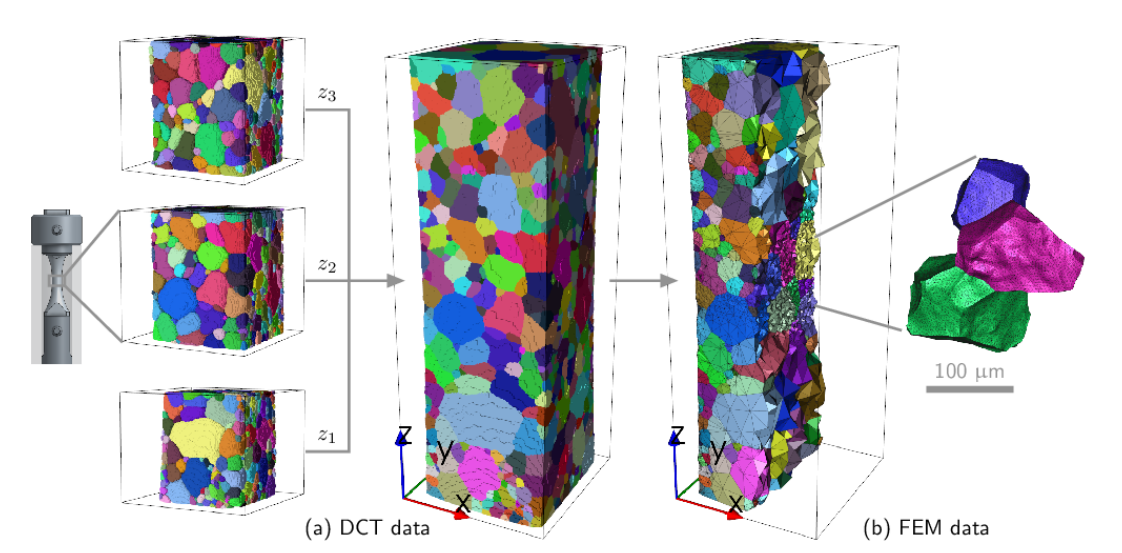
Figure 4. Comparison between the DCT data ( a ) and the mesh generated ( b ); the colors denote the grain numbers, which are consistent from the experiment to the simulation. Note the specimen shape with a radius in the gauge length as mentioned in Section